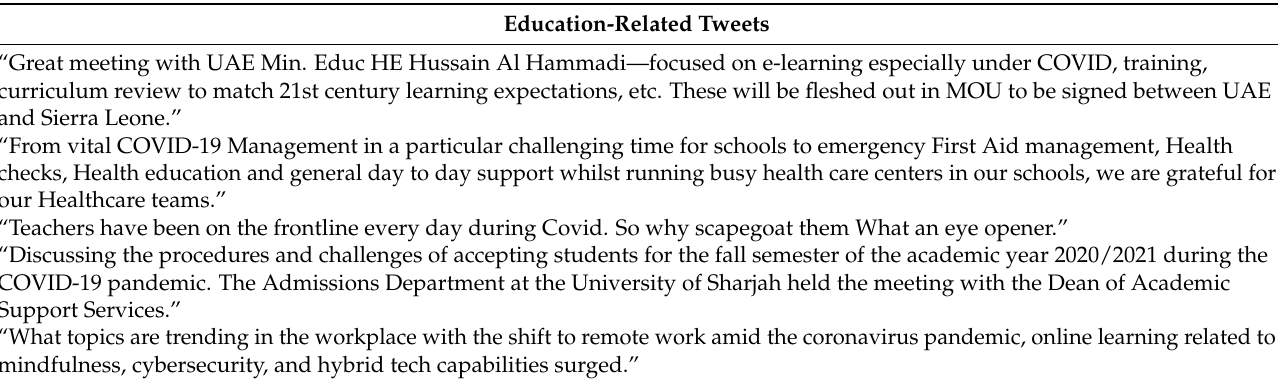
Table 3. Sample education-related UAE Twitter Chatter Data. Education-Related